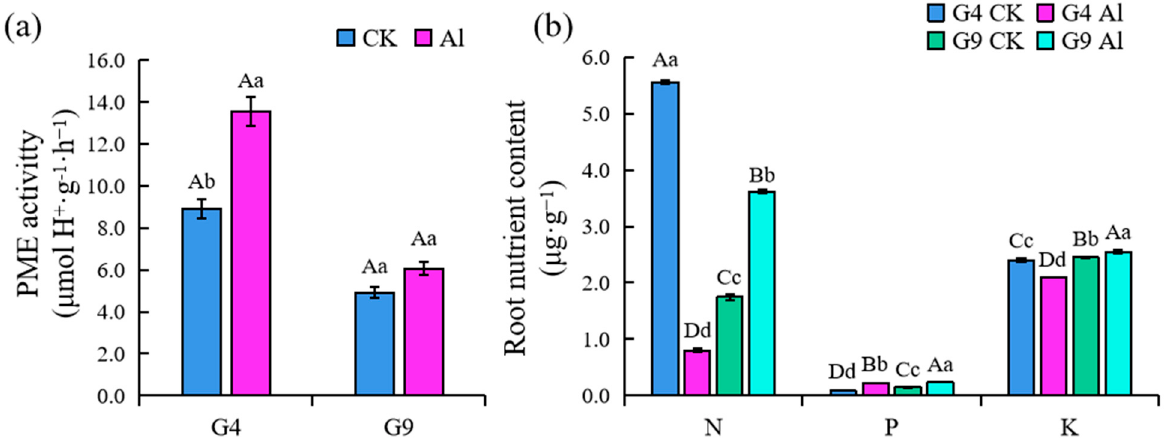
Figure 5. ( a ) PME activity in root tips and ( b ) N, P, and K content in roots of Eucalyptus clones G4 and G9. PME activity was determined colorimetrically. Note: different lowercase and uppercase letters indicate significant differences at the levels of 0.05 and 0.01, respectively. PME, pectin methylesterase; N, nitrogen; P, phosphorus; K, potassium.